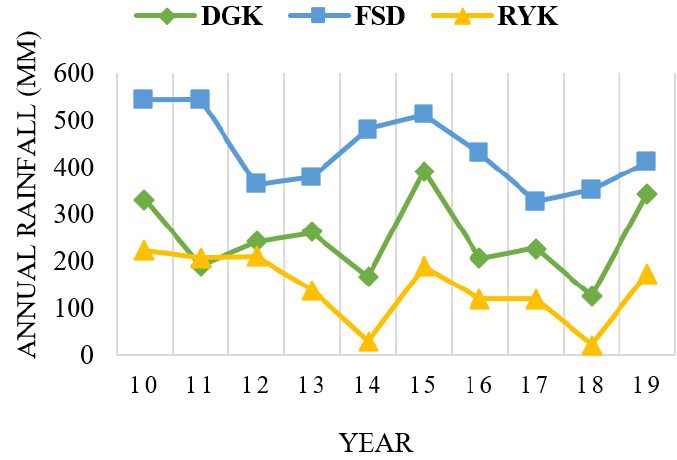
Figure 6. Annual rainfall in the study locations (2010–2019).